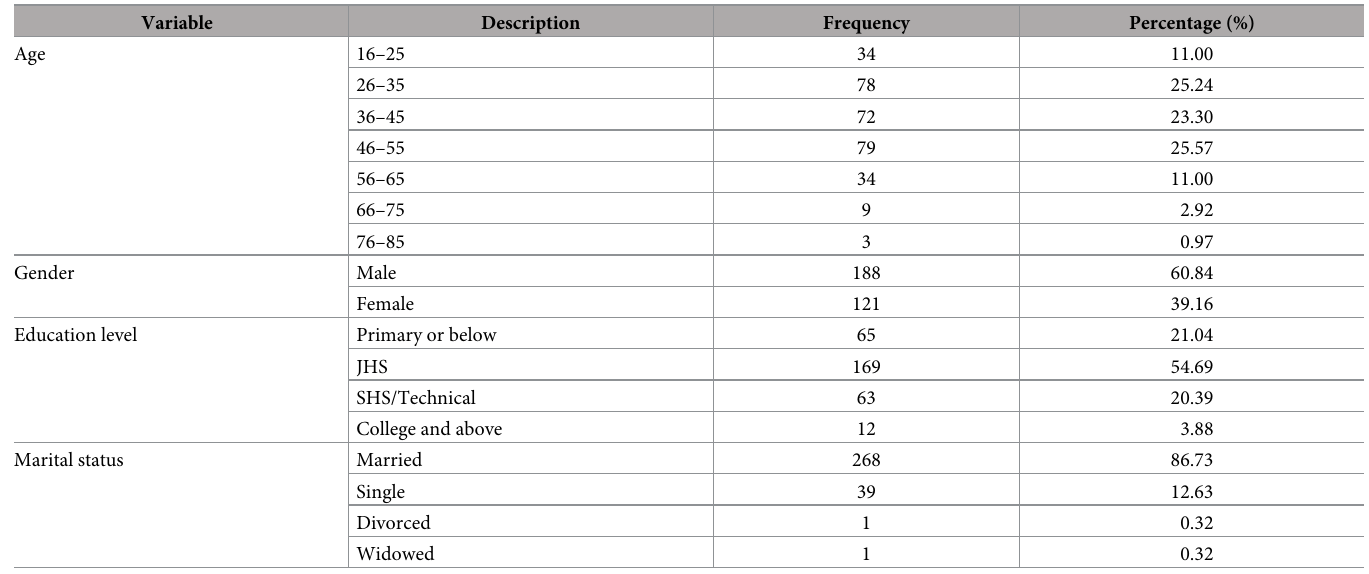
Table 1. Respondents’ demographic